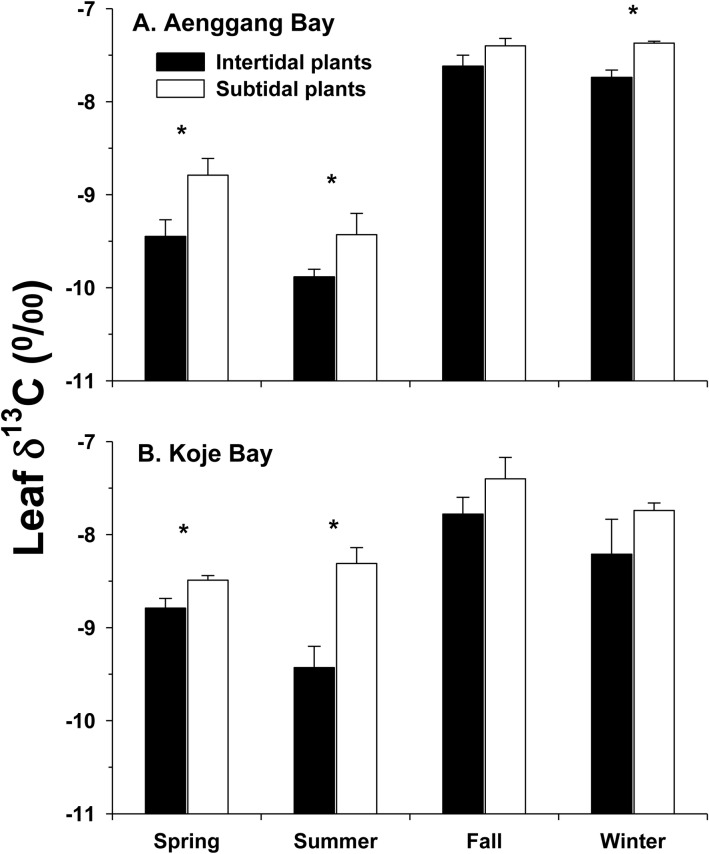
Zostera marina.Carbon stable isotope (δ13C) values of leaf tissues for the intertidal and subtidal plants in Aenggang Bay (A) and Koje Bay (B). Values are means ± standard errors (n = 6). An asterisk above the bar indicates a significant difference between the intertidal and subtidal plants in each season.